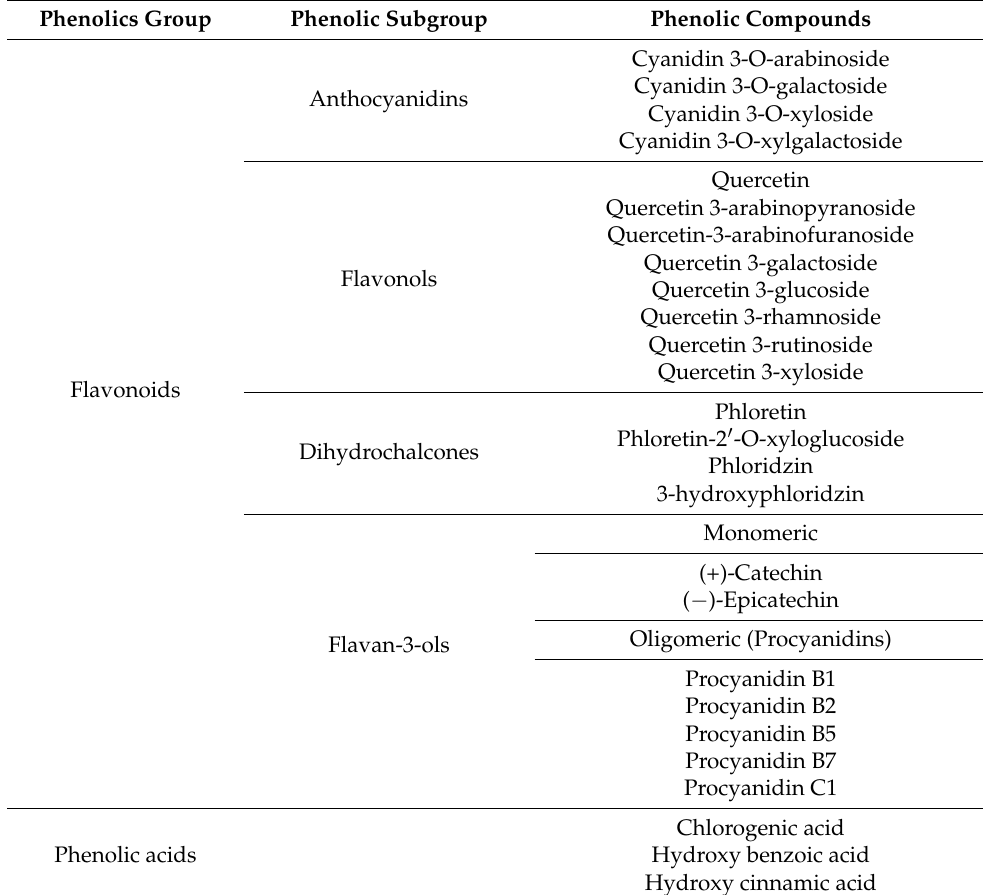
Table 1. Classification of apple